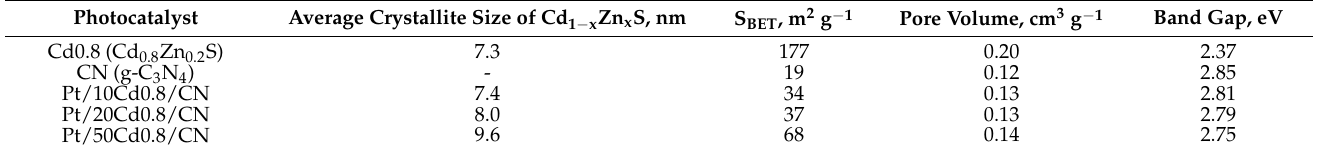
Table 2. Textural and optical properties of the ternary composite photocatalysts, Cd 0.8 Zn 0.2 S, and g-C 3 N 4 samples. Photocatalyst